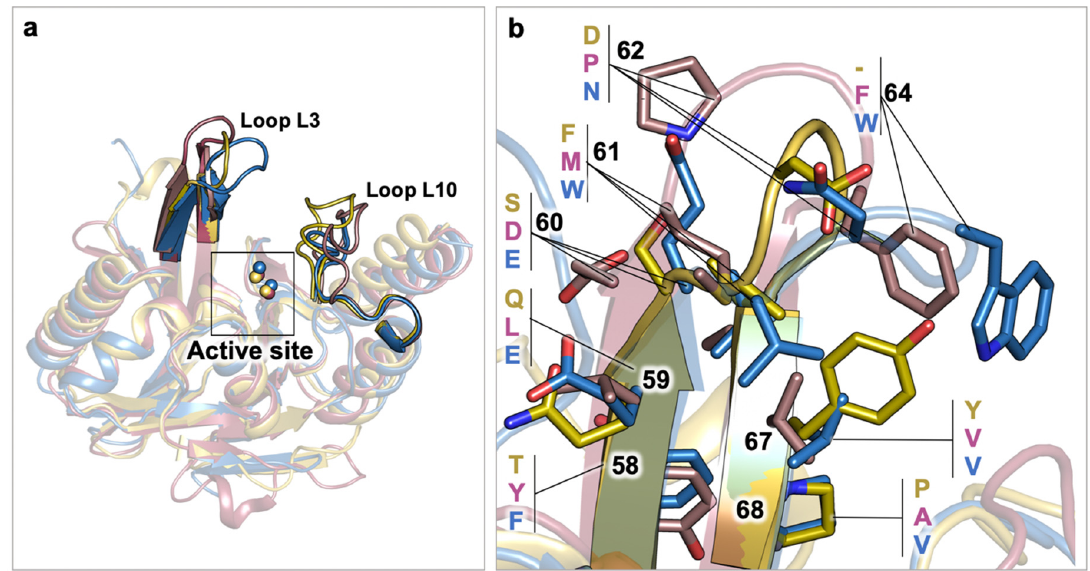
Figure 3. Structural comparison among subclass B1 BLs: VIM-2 (yellow, PDB ID: 4nq2), NDM-1 (pink, PDB ID: 3spu), IMP-1(blue, PDB ID: 1ddk). ( a ) Superposition highlighting loops L3 and L10. Proteins